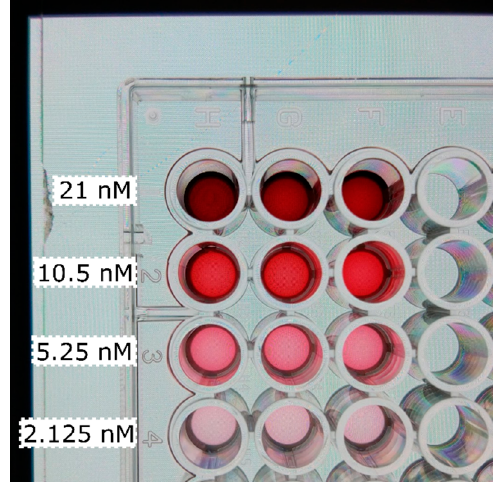
Figure 3. Image taken with the Xiaomi of colloid gold nanoparticles in a 96-well plate. Concentrations vary per row (as indicated). Each row (1–4) contains three replicas (H–F) used to construct the calibration curves. Backlight is provided using the white screen of the Huawei placed under the 96- well plate.